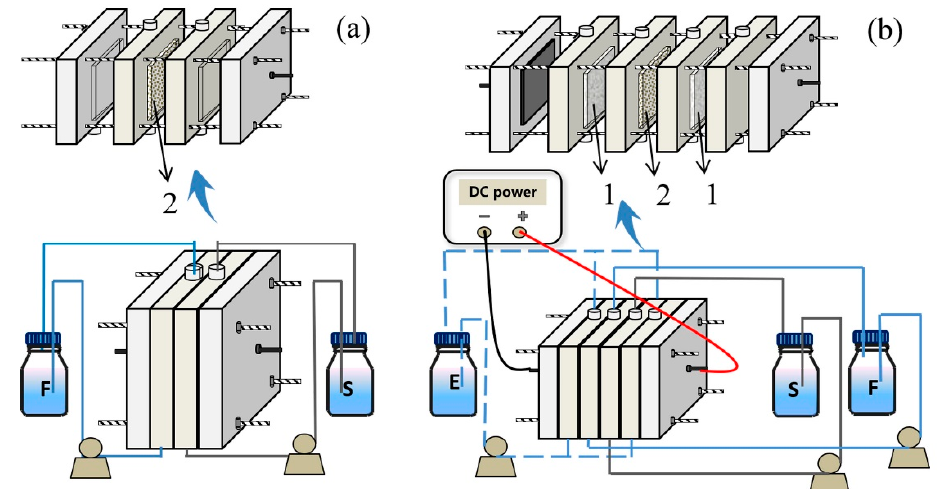
Figure 15. The experimental apparatus for the selective separation of VFAs ( a ) without the application of an electric field and ( b ) with the application of an electric field (1: Cation exchange membrane; 2: PIM; F: Feed solution; S: Stripping solution; E: Electrode